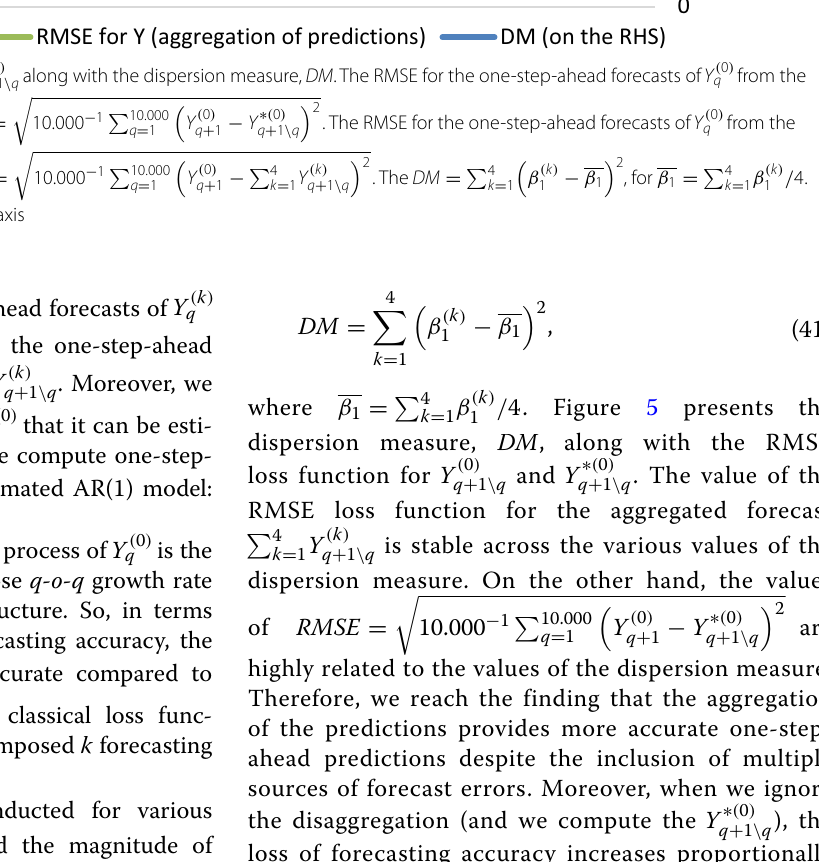
. The RMSE for the one-step-ahead forecasts of Y ( 0 )